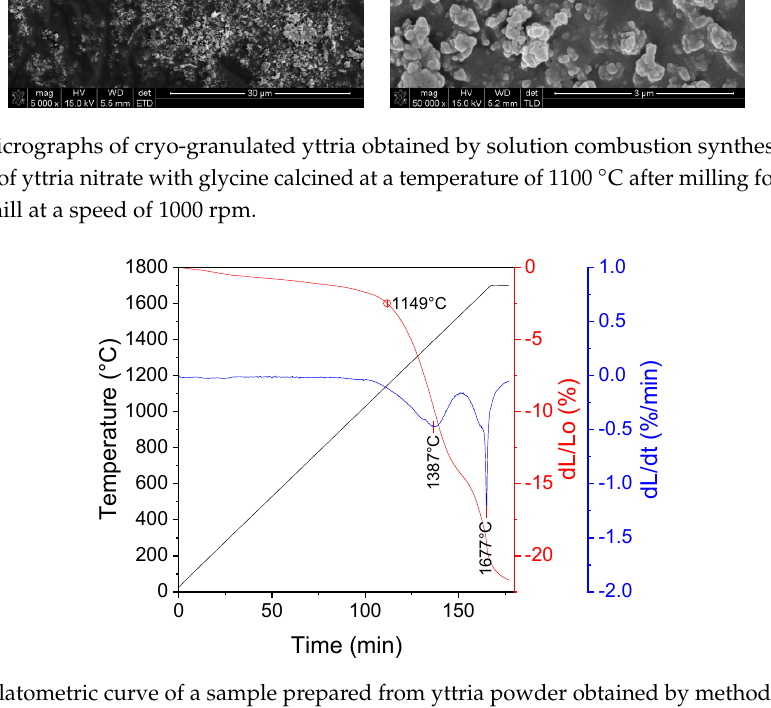
Figure 8. Dilatometric curve of a sample prepared from yttria powder obtained by method of the SCS with glycine.